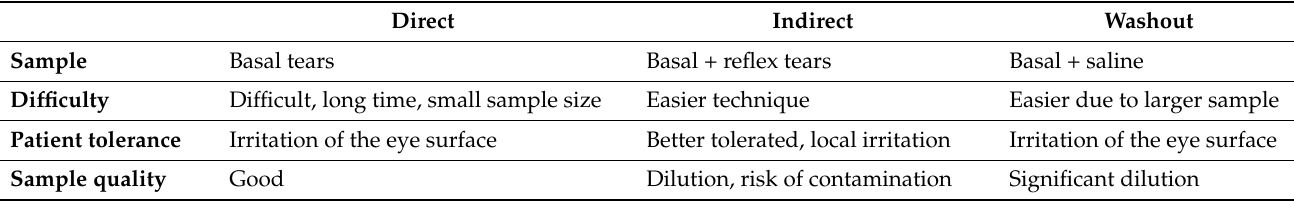
Table 1. Advantages and disadvantages of tear-collecting